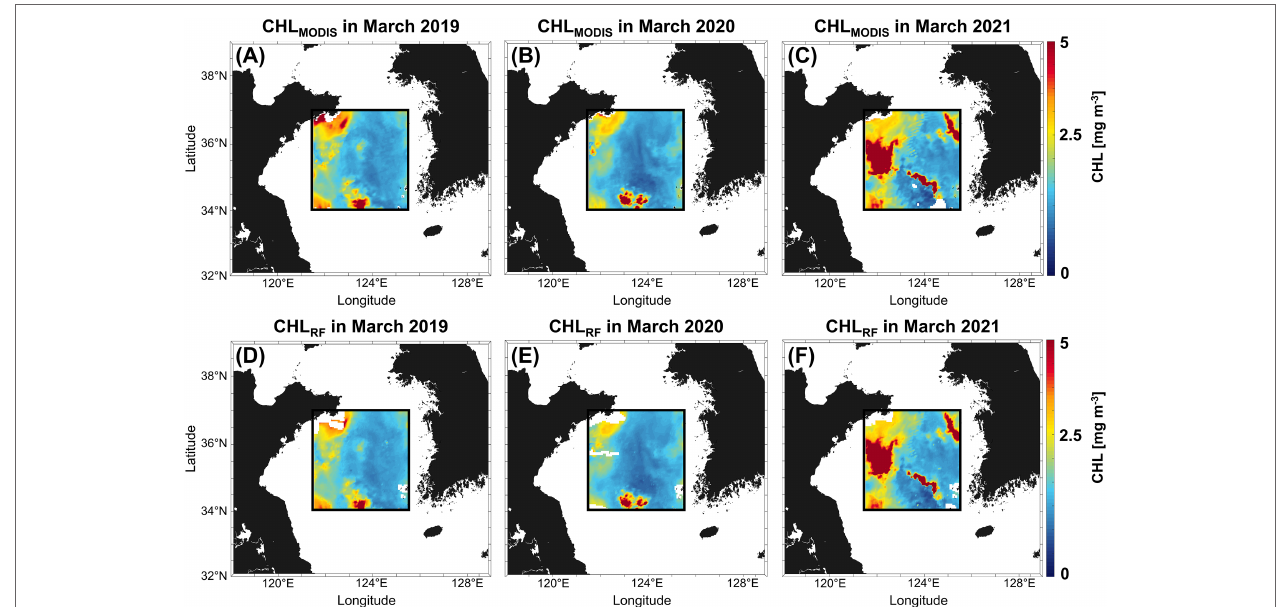
FIGURE 4 | Comparison of spatial patterns between the CHL MODIS (A–C) and CHL RF (D–F) from 2019 to 2021. The black boxes indicate the study